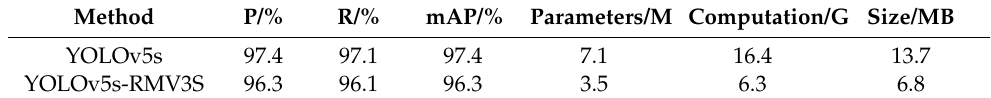
Table 1. Comparative experimental results of the improved process of the object detection module.